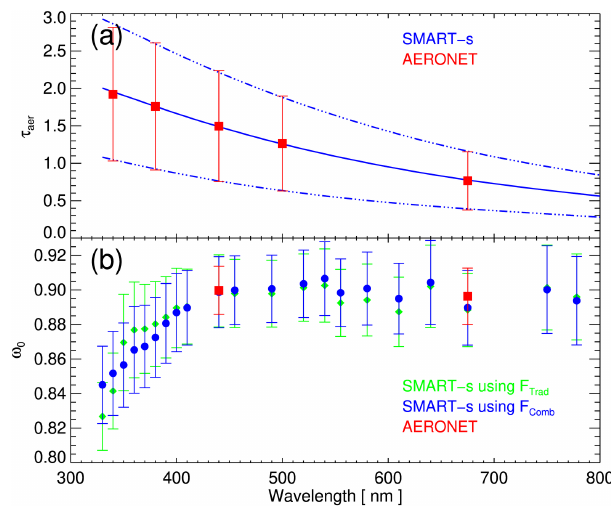
Figure 7. Mean values of (a) aerosol optical thickness ( τ aer ) from SMART–s (blue line) and AERONET (red square) within 330– 800nm spectral range measured from 19 March to 2 May 2019 at Fang, Thailand. Panel (b) shows the spectral single scatter- ing albedo of aerosols ( ω 0 ) from AERONET (red rectangle) and SMART–s, using different solar irradiance; green diamonds used Coddington et al. (2021), and blue circles used the spectrum de- rived in this study. Variabilities (1 standard deviation) of each value during the deployment period are shown as dash-dotted lines in panel (a) and vertical bars in panels (a) and (b) .